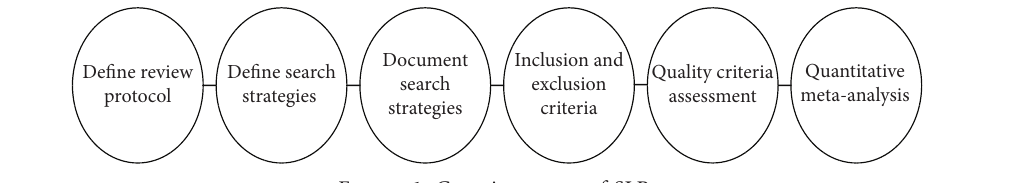
Figure 1: Generic process of SLR.